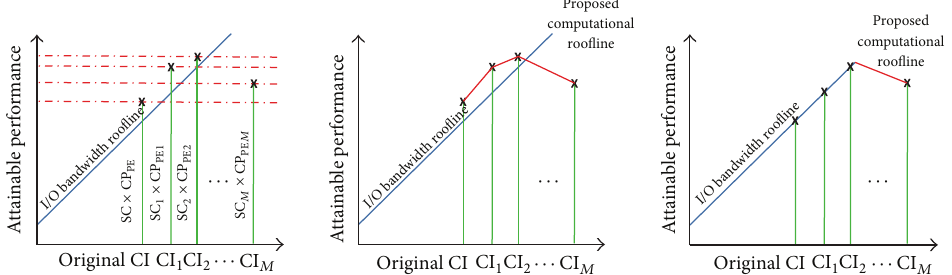
Figure 4: The benefit of a high CI is not so evident when the SC is also considered. The attainable performance is limited by the I/O bandwidth as well as the CP of the